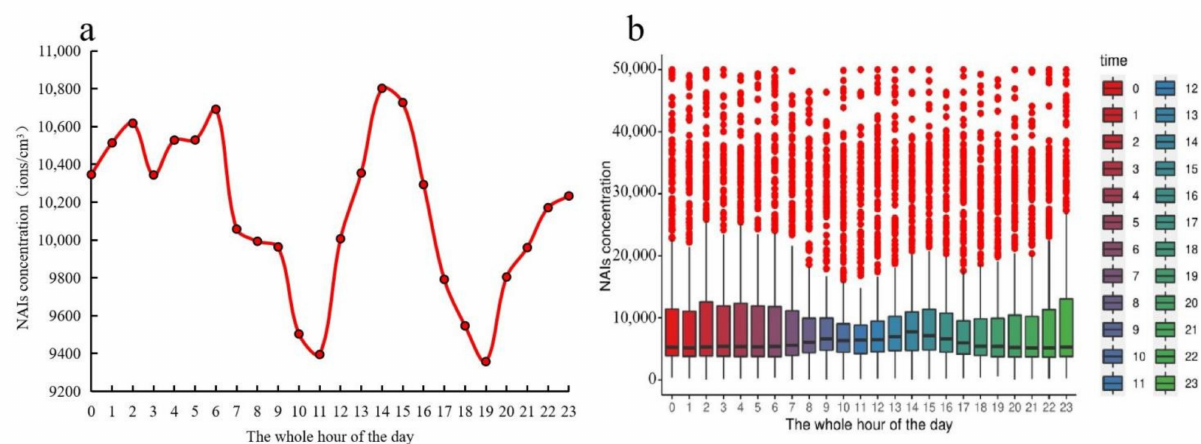
Figure 5. Daily distribution of hour-by-hour value of NAI concentrations. ( a ) Average hourly value of NAI concentration distribution a day. ( b ) Boxplot of NAI concentrations of raw hourly data. The value of the boxplot includes outliers, maximum, third quartile, median, first quartile and